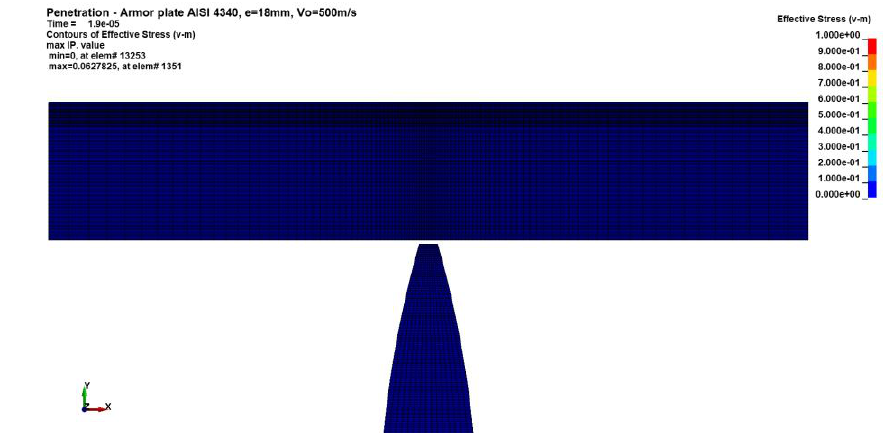
Figure 24 – Von Misses equivalent stress, time of analysis 0.01 ms – Model 4 Рис. 24 – Von Misses эквивалентное напряжение, время анализа 0.01 ms – Модель 4 Слика 24 – Von Misses-ов еквивалентни напон, време анализе 0,01 ms – модел 4